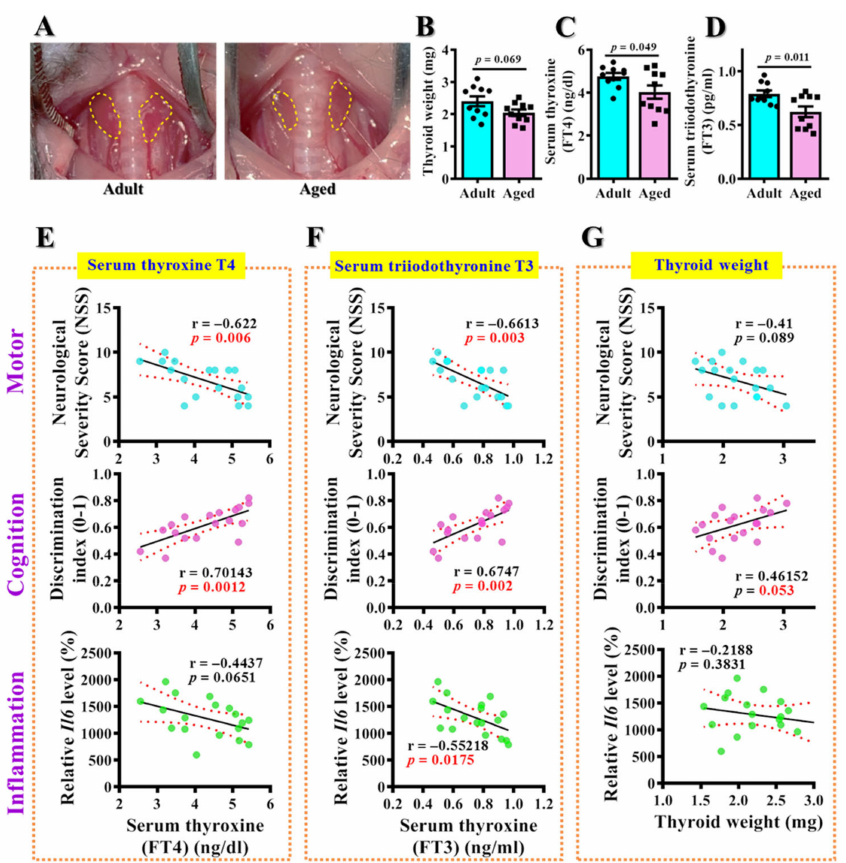
Figure 3. Correlation of thyroid function to the TBI-susceptible phenotypes. ( A ) Representative images showing the anatomical outlines of bilateral thyroid lobes from adult and middle-aged animals; ( B – D ) Quantification of the thyroid weight, serum free T4 and free T3 levels. n = 8 to 10 mice. Data are presented as mean ± SEM and are analyzed by a two-tailed unpaired t -test. ( E ) Pearson’s correlation plots between individual serum T4 with their behavioral or inflammatory indexes after CCI; ( F ) Pearson’s correlation plots between individual serum T3 with their behavioral or inflammatory indexes after CCI; ( G ) Pearson’s correlation plots between individual thyroid weight with their behavioral or inflammatory indexes after CCI. n = 20